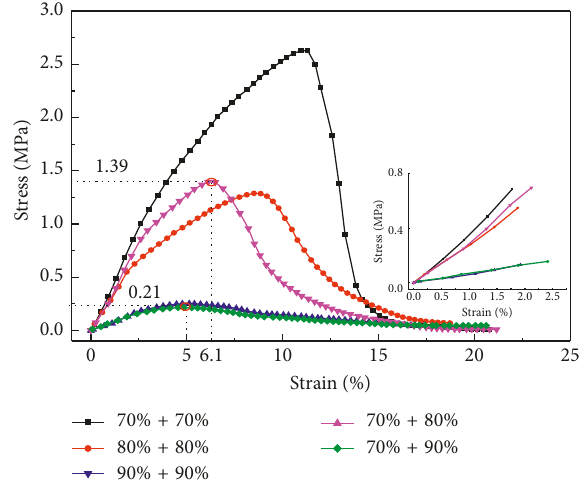
Figure 11: Uniaxial tensile stress-strain curves of soldered PCFSSs with different